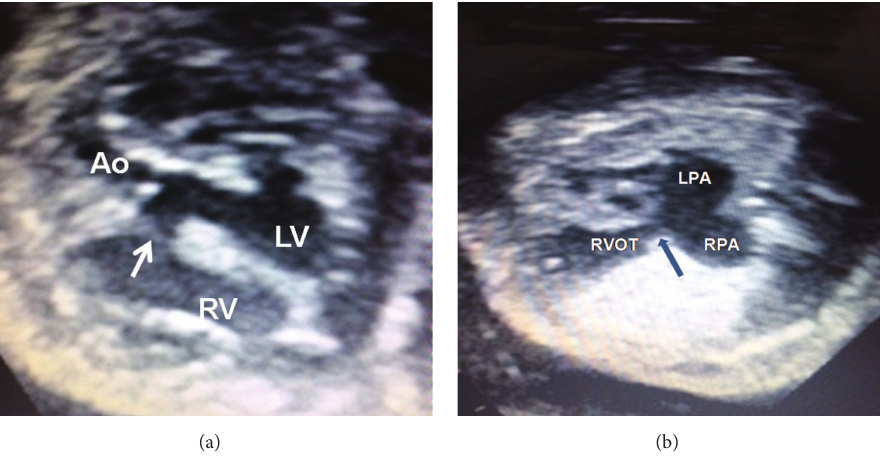
Figure 1: (a) This sagittal image reveals a large subaortic ventricular septal defect (white arrow) between the right ventricle (RV) and the left ventricle (LV). Aorta originating from the left ventricle is 50% dextroposed. (b) A coronal image of the fetal thorax reveals the aneurysmally dilated left pulmonary artery (LPA) and right pulmonary artery (RPA). Arrow indicates absence of pulmonary valve. RVOT: right ventricle outflow